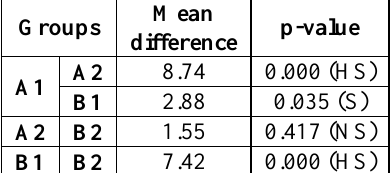
Table 2: Tukey HDS test of the shear bond strength subgroups.